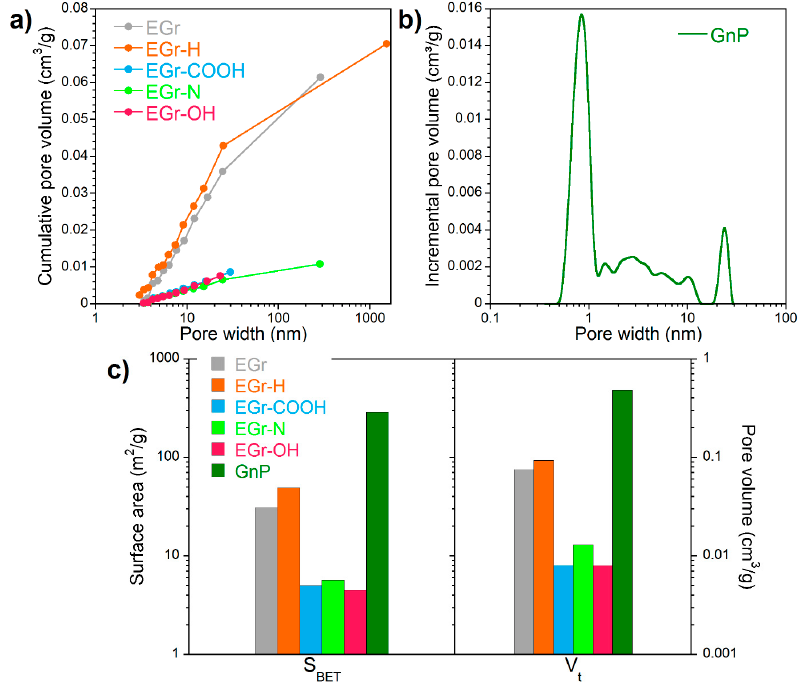
Figure 2. ( a ) Cumulative pore volume vs. pore width using Barrett-Joyner-Halenda (BJH) model; ( b ) Pore size distributions calculated using two-dimensional nonlocal density functional theory 2D-NLDFT and ( c ) specific surface area ( S BET ) calculated using BET model and total pore volume for the materials studied (in logarithmic scale).